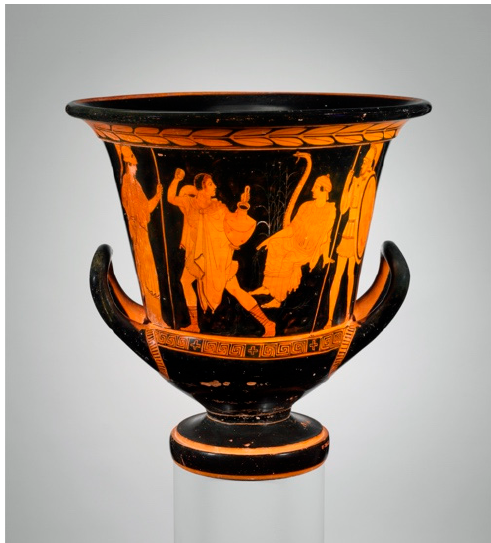
Figure 4. Kadmos and the Serpent (MMA acc. no. 07.286.66); red-figure calyx-krater; attr. to the Spreckels Painter; Attica; ca. 450 BCE . [Image courtesy of the open-access program of the Metropolitan Museum of Art, New York].